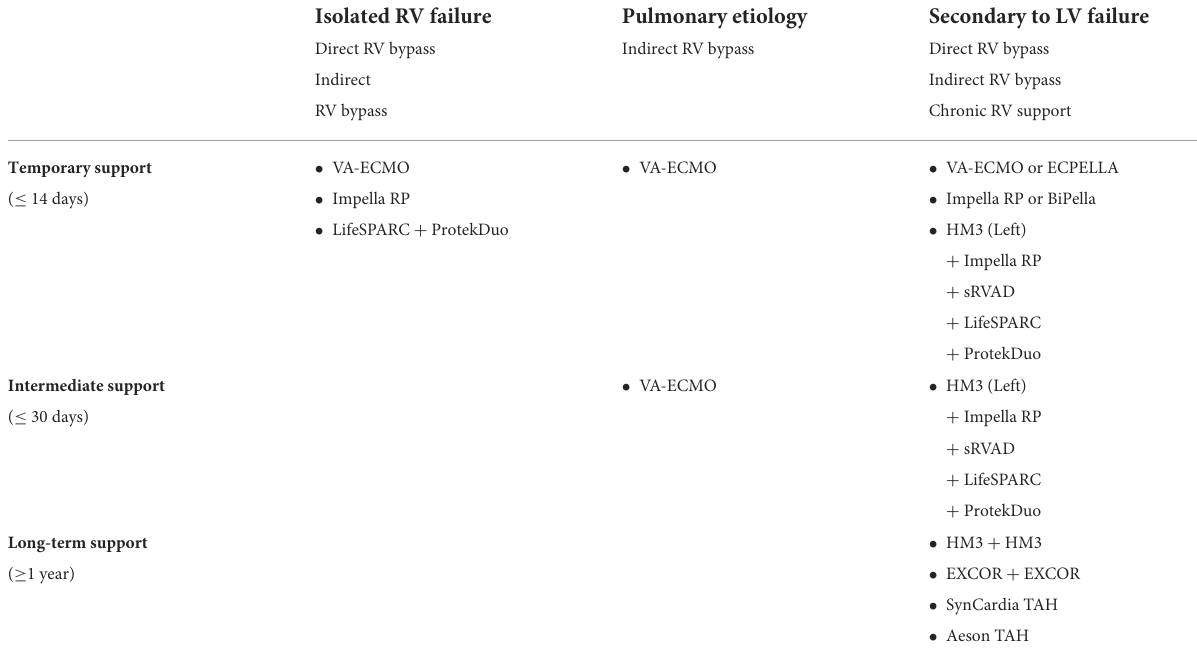
TABLE 1 Classification of the current mechanical circulatory support devices for RHF based on pathogenesis and the support